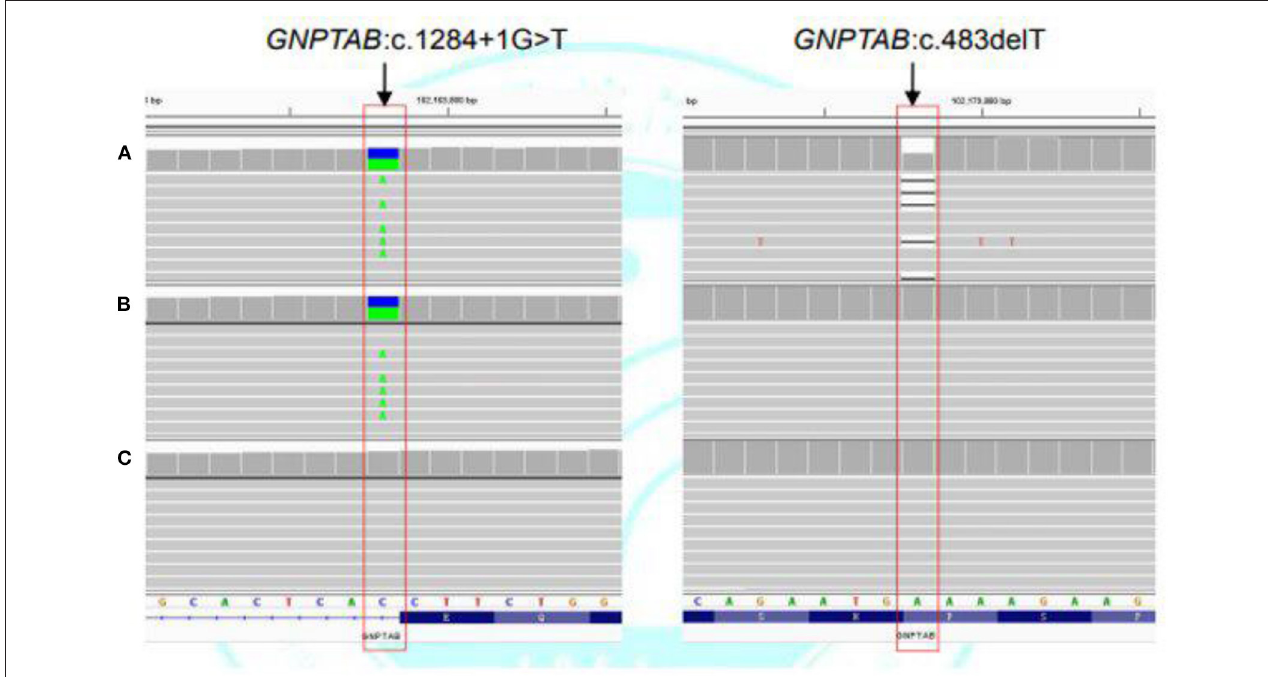
FIGURE 4 | Next-generation sequencing of the GNPTAB gene variants in case 2. (A) Heterozygous c.1284 + 1G > T and c.483delT variants in the GNPTAB gene of the patient. (B) Heterozygous c.1284 + 1G > T variant in the GNPTAB gene of the mother. (C) No pathogenic variant was detected in the GNPTAB gene of the